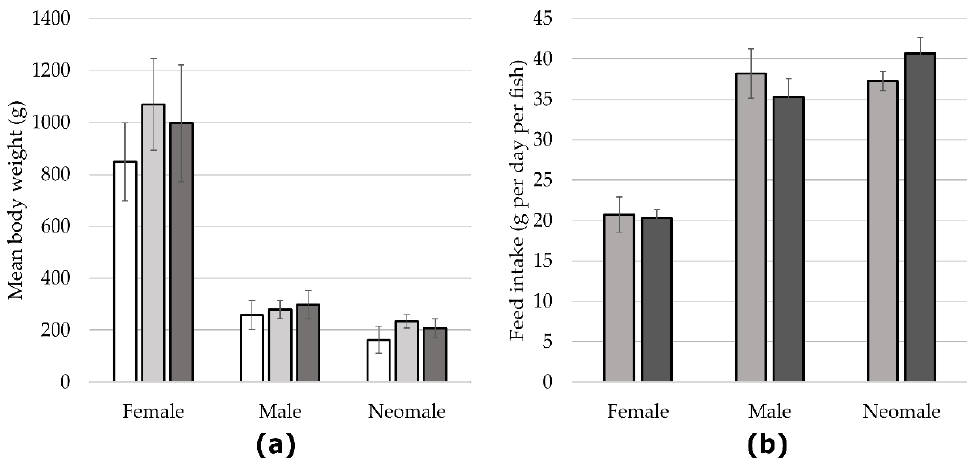
Figure 1. ( a ) Mean body weight and ( b ) feed intake of mature females and males and neomales fasted (white), fed with NC diet (non-carbohydrate diet, light grey) or fed with HC diet (high-carbohydrate diet, dark grey). Data ( n = 15 fish per sex and condition) were analysed with either one-way ANOVA when the conditions of application were respected or the Kruskal-Wallis test, followed by a post hoc Tukey’s test in case of significant differences ( p < 0.05, indicated by different letters).